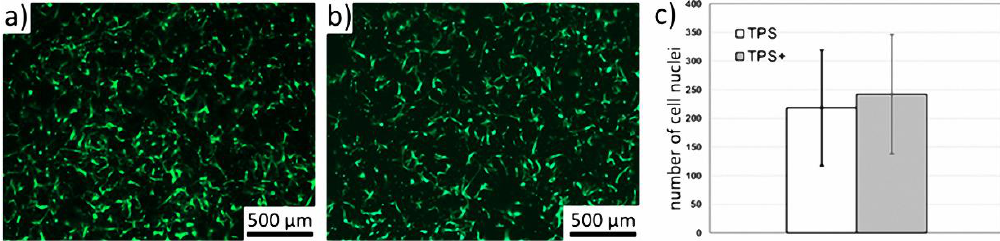
Figure 3. Representative fluorescence images of MSC cultured on ( a ) TPS and ( b ) TPS+ after 24 h incubation. The samples were stained with calcein-AM. ( c ) Quantification of adherent MSC on TPS and TPS+ samples. The quantification was performed by counting cell nuclei after staining with DAPI from respective fluorescence images.